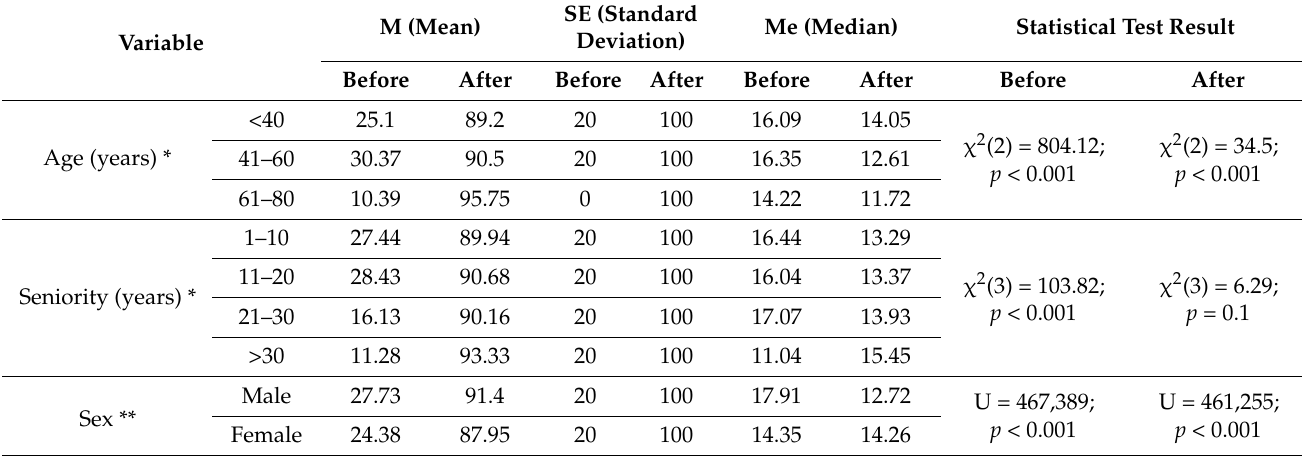
Table 5. Effect of age, professional service length, and sex on the percentage of correct answers given to the questions asked.